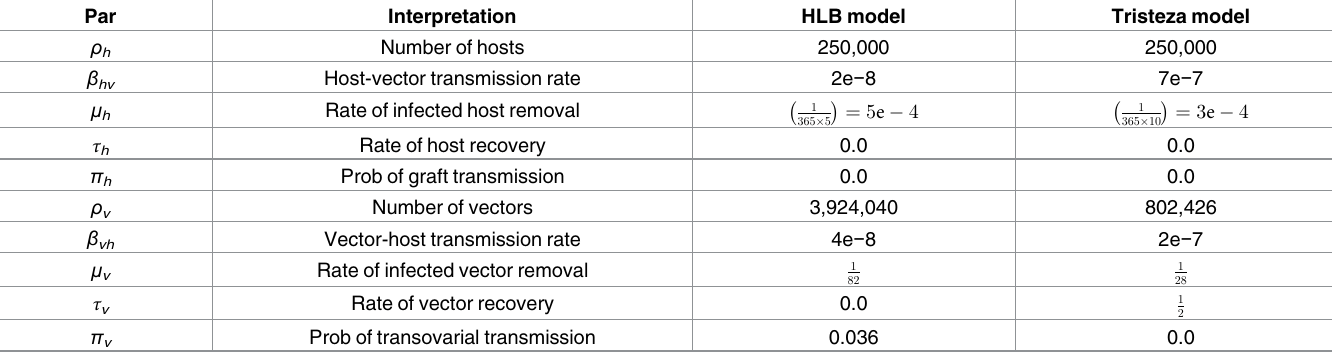
Table 2. Parametervalues for different models used in the current